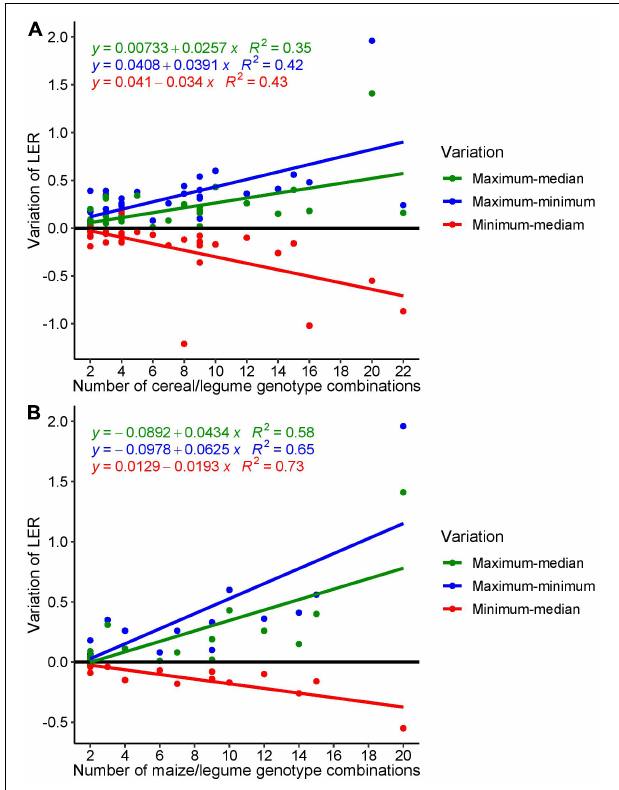
FIGURE 5 | Variation of extracted LER: (A) all data points from cereal/legume intercropping extracted from 35 studies and (B) LER variation from maize-based intercropping extracted from 16